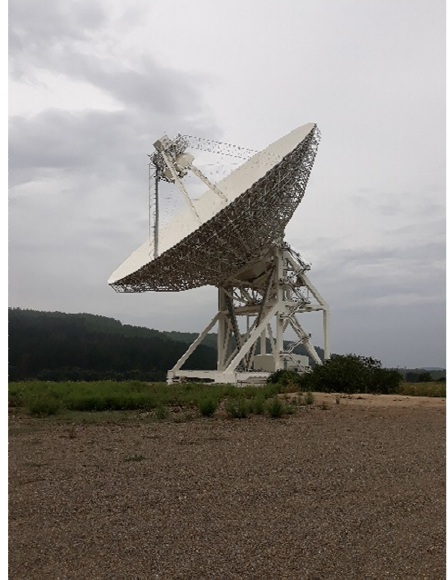
Figure 1. Photo of the Sardinia Radio Telescope (SRT). Table 1. Key features of the Sardinia Radio Telescope (SRT). BWG, beam waveguide system.